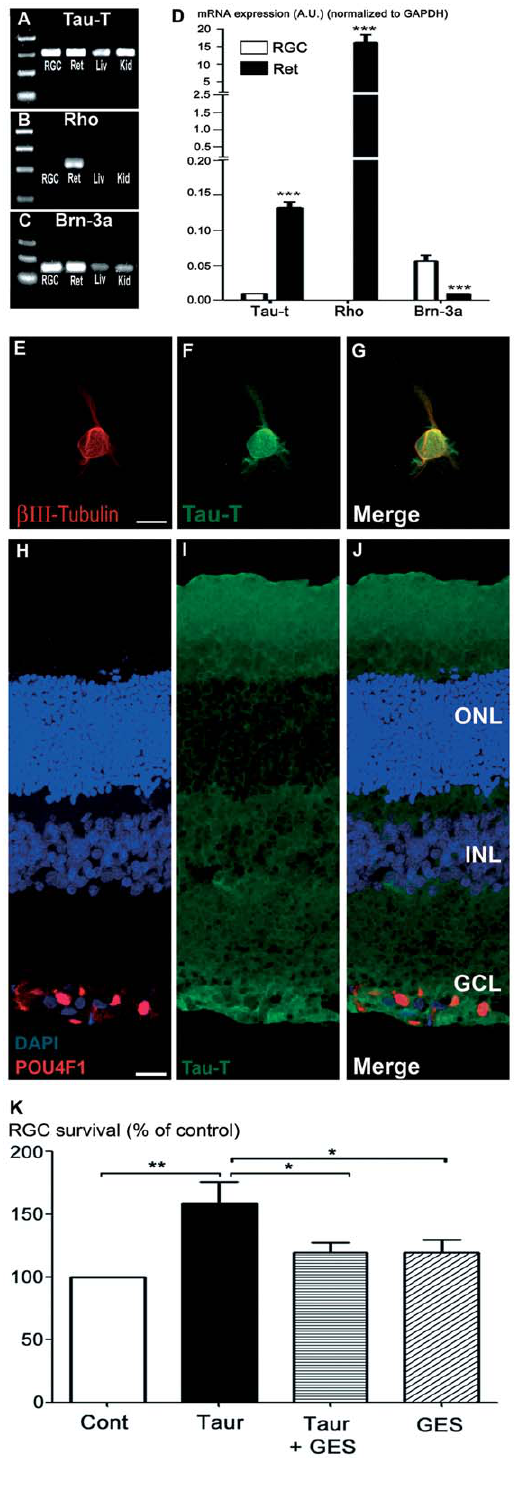
Figure 2. Implication of the taurine transporter in retinal ganglion cell (RGC) survival. A–C) Gene amplification (PCR) of the taurine transporter (Tau-T; A), rhodopsin (Rho; B) and POU4F1 (Brn-3a; C) performed on total cDNAs, previously obtained through a reverse transcription of total RNA extracted from freshly purified rat RGC (not cultured), rat full retina (Ret), rat liver (Liv), or rat kidney (Kid). Tau-T gene amplification revealed a high expression in pure RGCs (A). The purity of the RGC preparation was indicated by the high level of